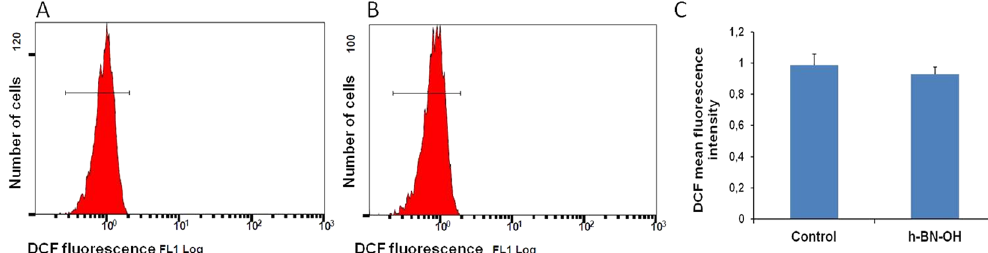
Figure 8. Effect of h-BN-OH-n on ROS formation in human erythrocytes. Histogram of DCF fluorescence in RBCs following exposure for 1 hour to ( A ) PBS and ( B ) h-BN-OH-n (10 − 7 g/ml). ( C ) Mean fluorescence intensity ( ± SD, n = 5) of the DCF in RBCs exposed to PBS (control) and h-BN-OH-n.